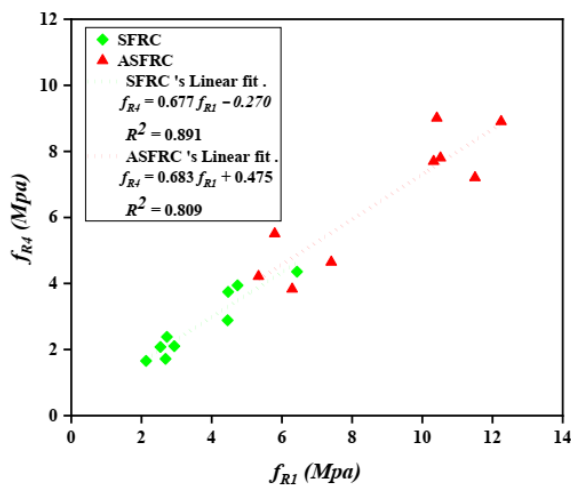
Figure 8. Relationship between residual flexural tensile strengths: f R 1 and f R 4 .